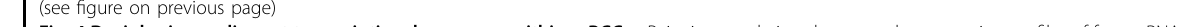
Fig. 4 Deciphering malignant transcriptional programs within ccRCC. a Pairwise correlations between the expression pro fi les of four scRNA-seq samples (3564 cells). b Heatmap of average correlations across four samples between pairs of programs. c Dot plot showing signi fi cantly enriched pathways for signature genes of each meta-program. The color shade of the dot indicates the P value after FDR correction (the redder, the smaller adjusted P value), and the size of the dot represents the number of genes in the indicated pathway (the larger, the more genes included). d , e The Kaplan – Meier overall survival curves of TCGA-KIRC patients grouped by the average gene expression of meta-program 1 and meta-program 2 (with the median as the threshold). The P value was calculated by the log-rank test. HR, hazard ratio. f , g Sankey diagrams showing the regulatory relationship between the four tumor-speci fi c TFs and genes within meta-program 1 and meta-program